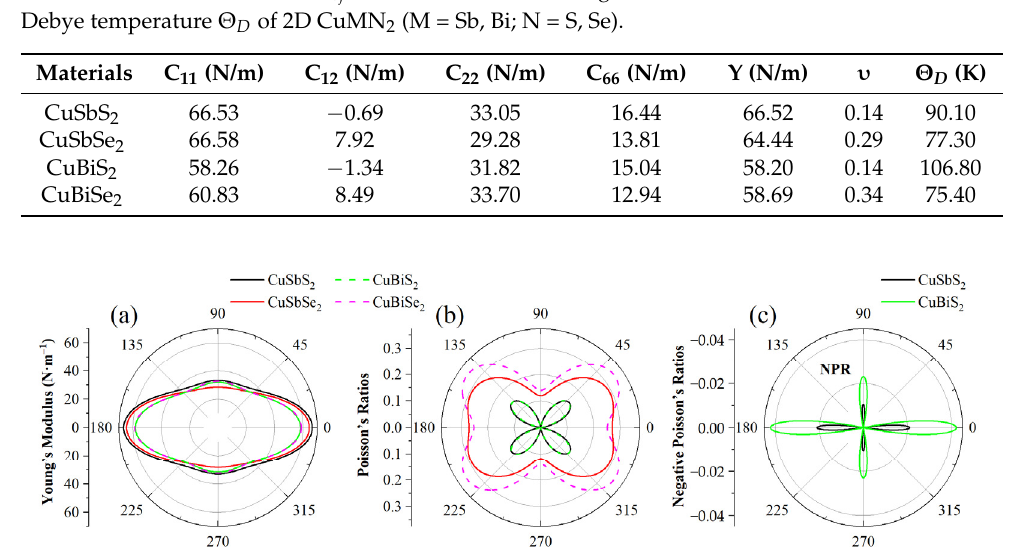
Table 2. The Elastic constants C ij , the maximums for Young’s modulus Y and Poisson’s ratio υ , and